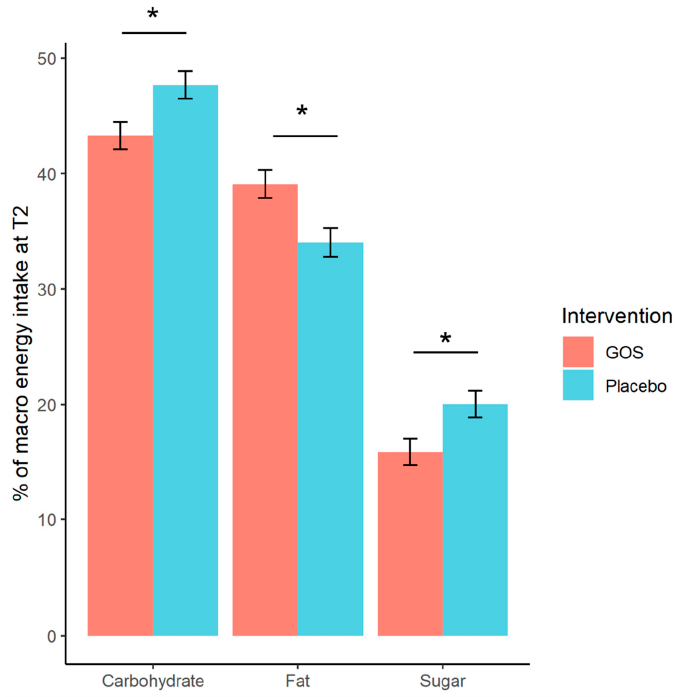
Figure 1. Significant treatment effects from ANCOVA tests on nutrient intake at T2 for carbohydrates, fat, and sugars ( n = 23 in each group). The GOS intervention shows reduced total carbohydrate and reduced sugars compared to the placebo group and increased total fat intake. Error bars are standard error of the mean. * p < 0.05.